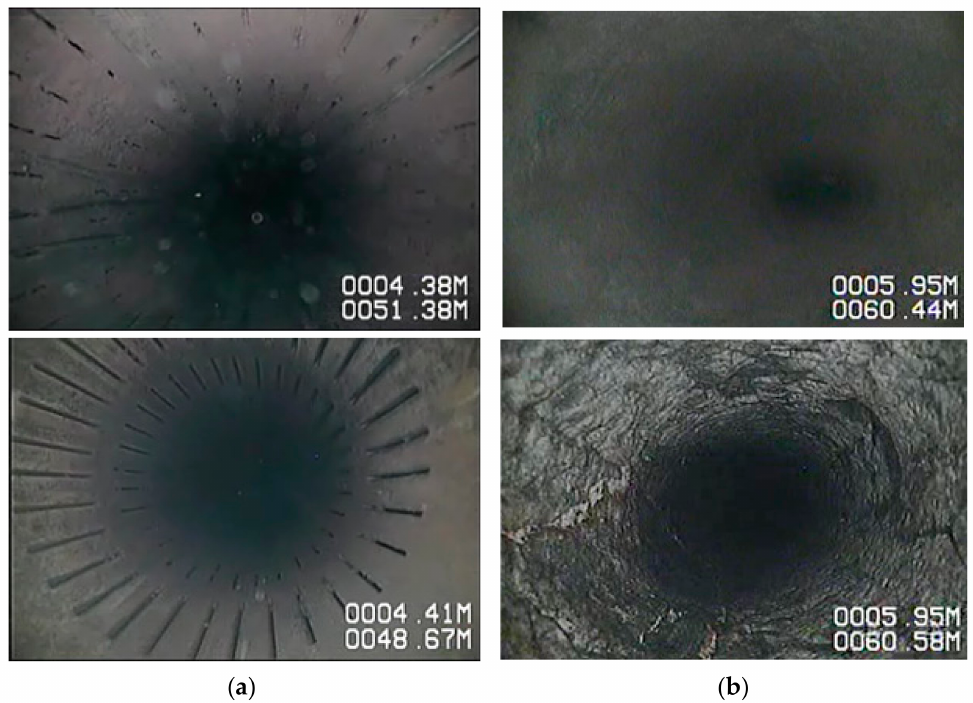
Figure 2. Air surging operation ( top ) and well screen and groundwater quality comparisons before ( middle ) and after ( bottom ) surging from a borehole camera in the ( a ) D-8, and ( b ) D-7 wells.